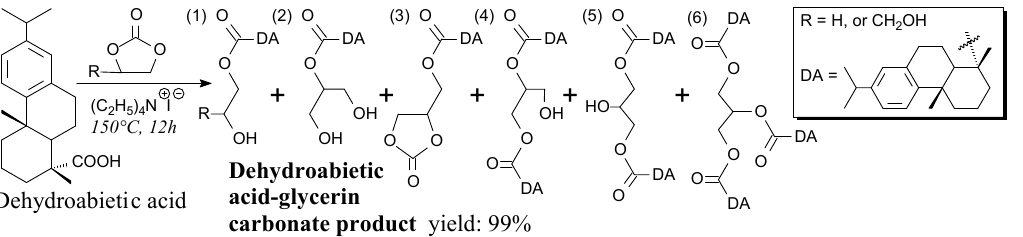
Scheme 78. Preparation of rosin-glycerin carbonate xerographic toner.